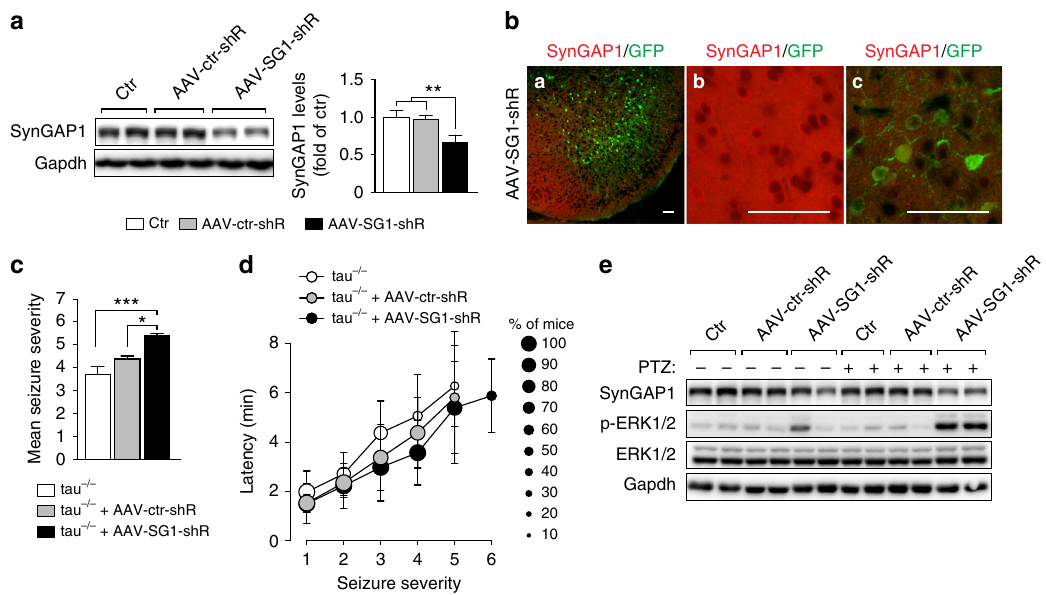
Fig. 7 Reducing SynGAP1 levels in tau − / − mice reinstates susceptibility to seizures and ERK activation. a Neonatal (P1-3) wild-type C57Bl/6 mice were injected intracranially with AAVs expressing either shRNA to knockdown SynGAP1 (AAV-SG1-shR) or control shRNA (AAV-ctr-shR). Western blotting of cortical extracts from 2-month-old naive (ctr) and AAV-injected mice showed marked reduction of SynGAP1 levels in AAV-SG1-shR-injected mice. Quanti fi cation of band intensities con fi rmed signi fi cant SynGAP1 reduction by AAV-SG1-shR (** p < 0.01; N = 9; one-way ANOVA (Tukey post hoc)). b Example of GFP reporter expression in neurons throughout the cortex of AAV-SG1-shR-injected mice. Double labeling with a SynGAP1 antibody ( red ) revealed SynGAP1 expression in areas with no GFP expression and marked reduction of SynGAP1 in GFP-positive areas, suggesting ef fi cient knockdown. Higher magni fi cation of areas with neuronal and synaptic SynGAP1, but no GFP expression ( middle ), or neuronal GFP reporter expression with reduced SynGAP1 ( right ). Scale bars , 100 µ m. c AAV-SG1-shR, but not AAV-ctr-shR injection increased the mean seizure severity in tau − / − mice after administration of 50 mg/kg PTZ (* p < 0.05; *** p < 0.001; N = 11 (tau − / − ), N = 13 (AAV injected tau − / − ); one-way ANOVA (Tukey post hoc)). d More tau − / − mice injected with AAV-SG1-shR developed higher degree seizures after administration of 50 mg/kg PTZ, compared with naive (ctr) or AAV-ctr-shR-injected tau − / − mice. The latency of seizure progression was comparable. e Strong ERK1/2 phosphorylation 10 min after 50 mg/kg PTZ administration in AAV-SG1-shR- injected, but not AAV-ctr-shR-injected or naive (ctr) tau − / − mice, together with reduction of SynGAP1 levels. Detection of ERK1/2 and Gapdh con fi rmed equal loading. All error bars are